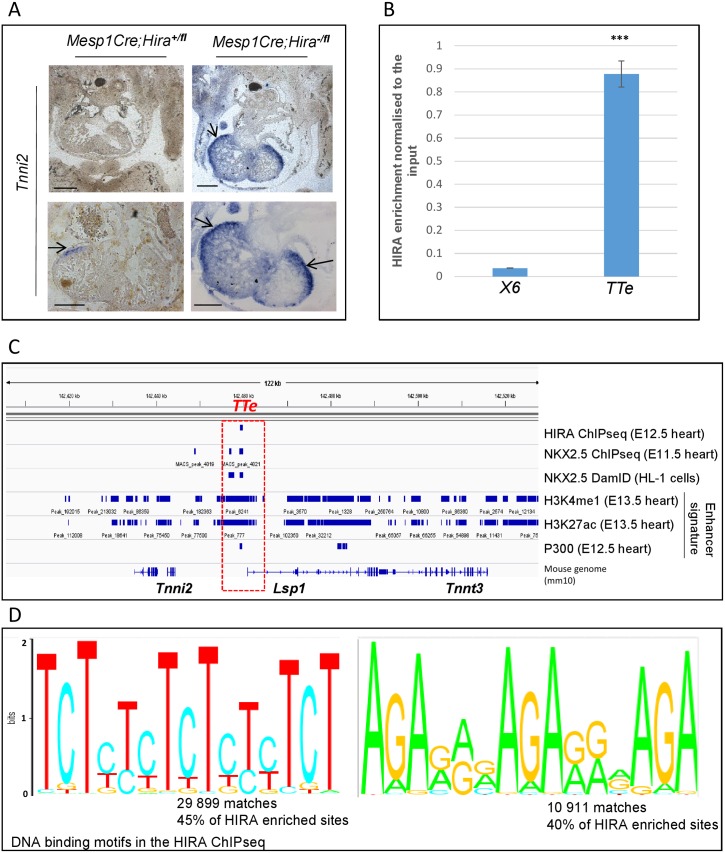
HIRA is enriched in the vicinity of Tnni2/Tnnt3, which is upregulated in conditionally deleted Hira mutants, and binds GAGA rich DNA.A.
In situ hybridization Tnni2 on transverse sections of E12.5 embryos with the indicated genotype, revealed an abnormally increased expression of Tnni2 particularly in the ventricular free wall of the mutant hearts (arrows). Scale bar: 100μm
B. qChIP of the HIRA enrichment at the TTe locus. An intergenic region on chromosome 6 was used as a negative control. Data is normalized to the input (= 100) and is representative of 2 independent experiments. Errors bars represent the min/max from technical duplicates. Unpaired t-test: p<0.001 *** C. IGV profile showing the HIRA ChIP seq peak present at the Tnni2/Lsp1/Tnnt3 (TTe) site (situated 17Kb downstream of Tnni2 and 34Kb upstream of Tnnt3), co-localizing with NKX2.5 ChIPseq peaks (E11.5 heart [11]), NKX2.5 DamID peaks (HL-1 cell line [12]), and the active enhancer marks H3K4me1 and H3K27Ac ChIPseq peaks on WT E13.5 hearts (encode database ENCSR663VWL) and P300 (WT E12.5 heart [23]). D. The Matrix-based nucleotide profiles display here the motifs that HIRA binds most frequently. 45% of HIRA enriched sites contained a GAGA/TCTC motif.